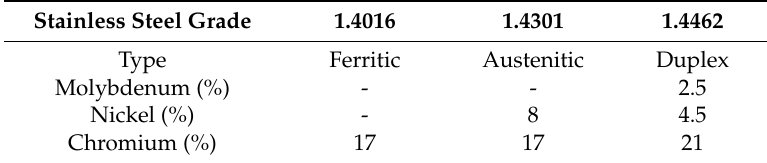
Table 1. Main alloy element compositions according to EN10088